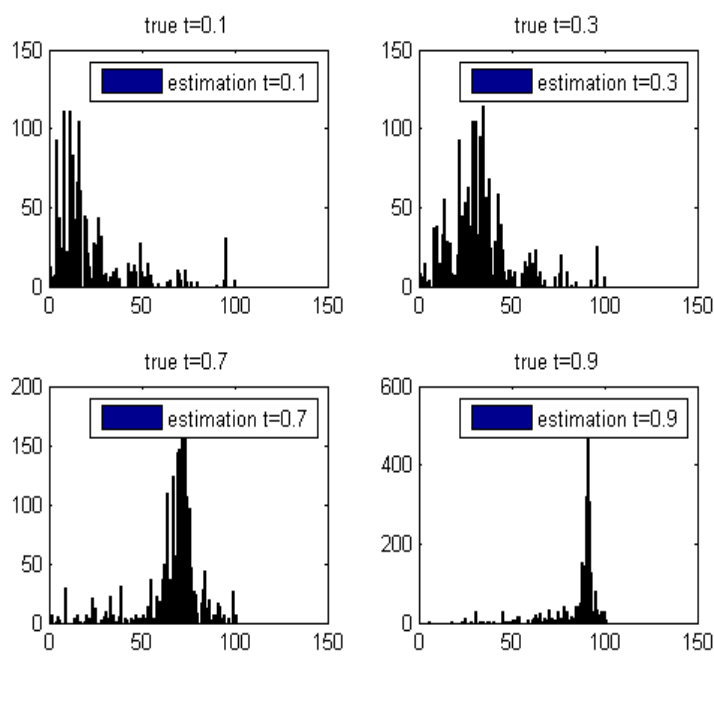
Figure 11. The spectra T and B of different materials from the database of signatures, where the x- and y-axes are the wavebands and their values, respectively